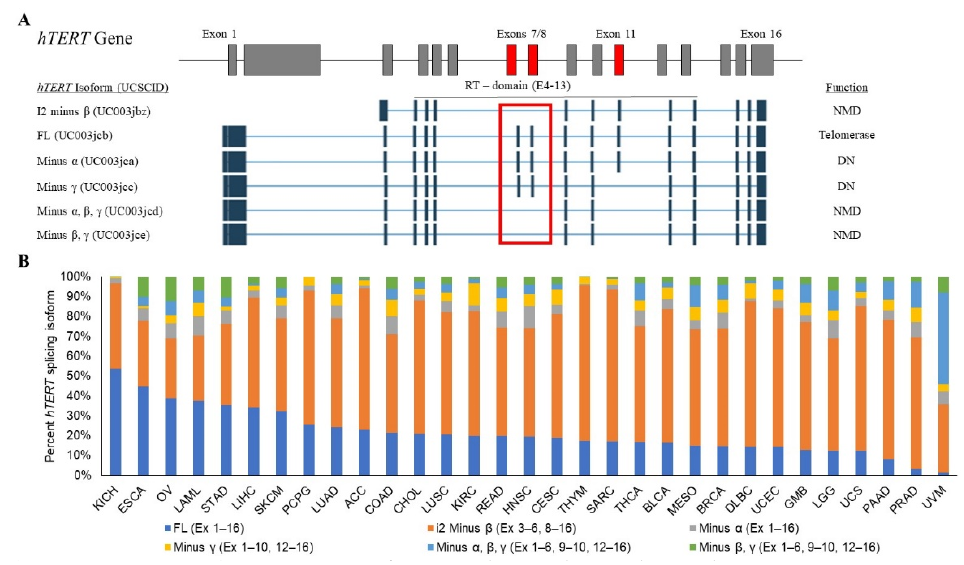
Figure 1. Common hTERT gene isoforms and prevalence observed across 31 tumor types as determined by the TSVdb. ( A ) A cartoon of the common hTERT splicing isoform structures observed across 31 tumors. Only the complete 16 exon containing FL transcript produces the catalytically active telomerase enzyme. On the contrary, all other alternatively spliced, catalytically inactive isoforms that include a combination of the -α, -β, and -γ exon skipping events are known or predicted to act as a dominant negative or target the transcript for nonsense-mediated decay, and thus yield cells telomerase negative. ( B ) The percentage of each hTERT splicing isoform categorized in 31 individual tumors types, demonstrating that the -β splicing event (exons 7 and 8 skipping) is the most prevalent. Abbreviations: ACC: adrenocortical carcinoma; BLCA = bladder urothelial